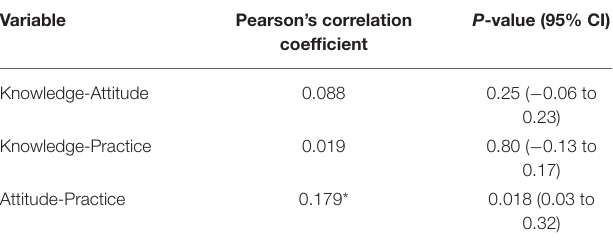
TABLE 6 | Correlation between scores of knowledge, attitude, and practice ( n =